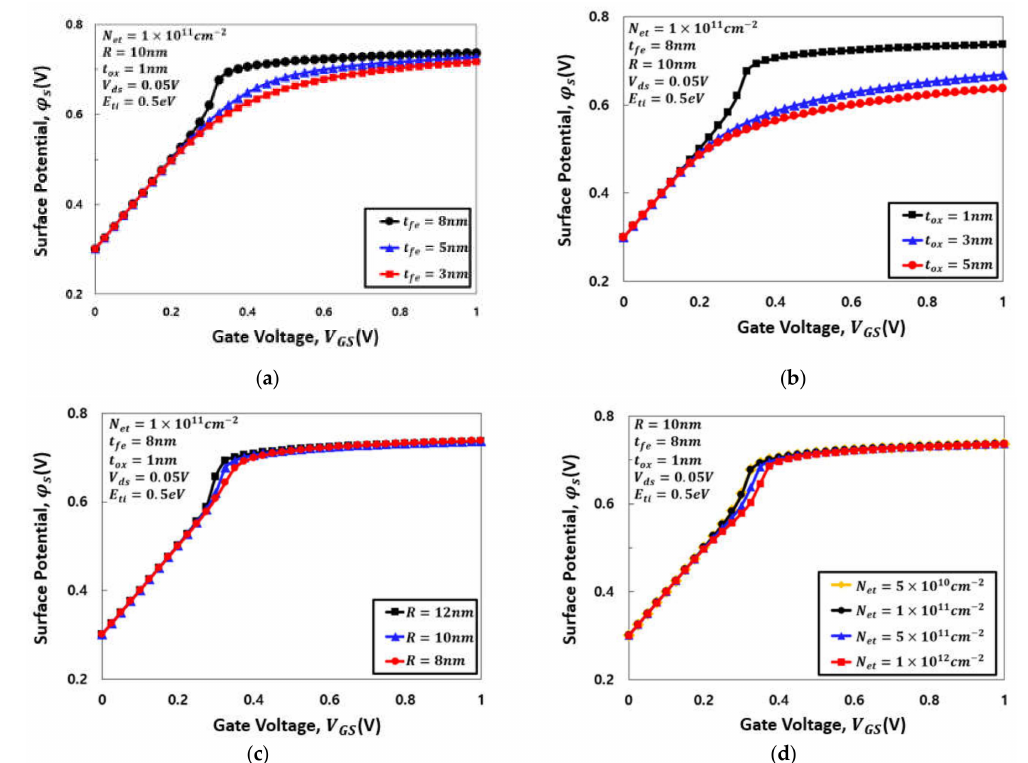
Figure 3. Electrostatic surface potential versus gate-to-source voltage ( a ) varies with ferro-electric material thickness; ( b ) varies with oxide thickness; ( c ) varies with radius; and ( d ) varies with interface trap density per unit surface.